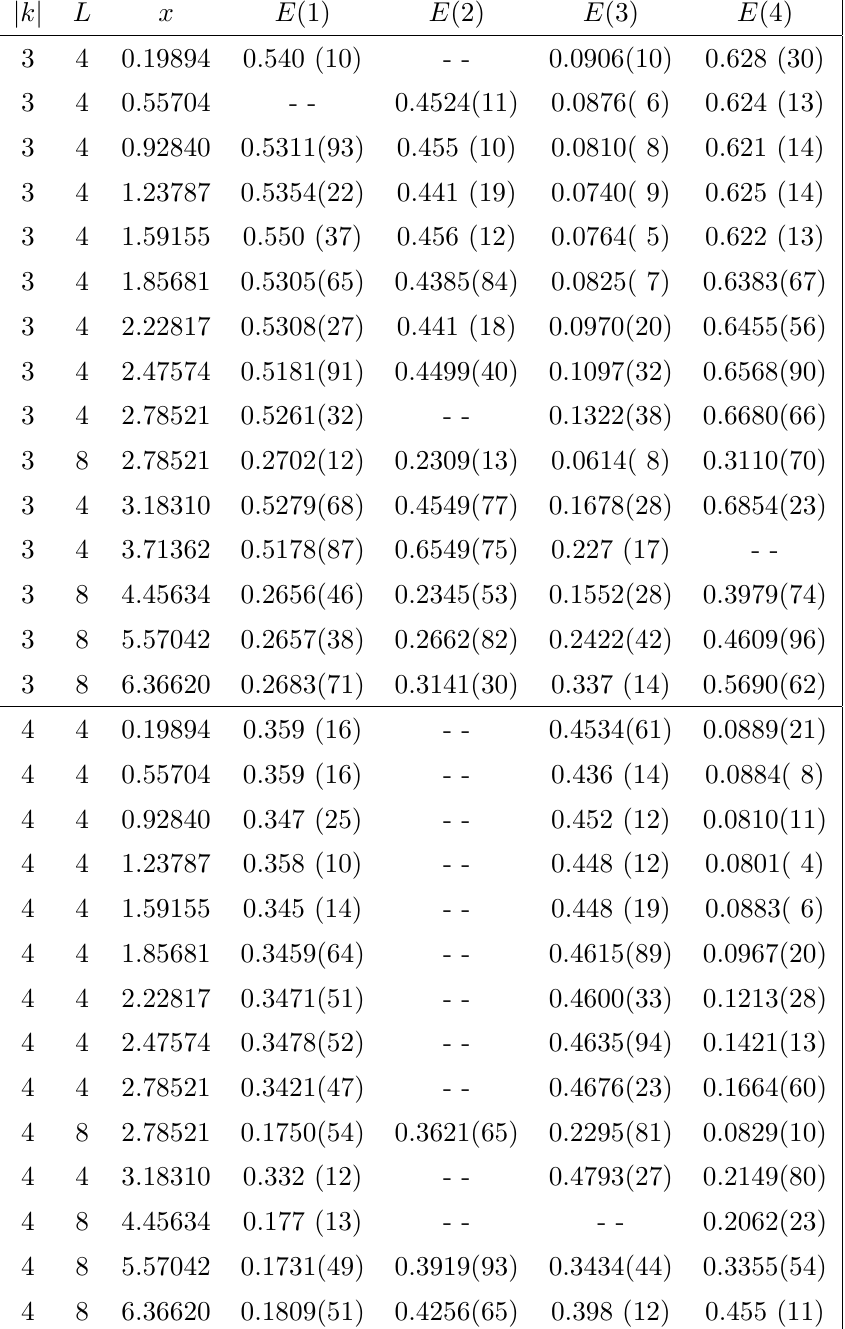
Table 10. SU(17) torelon energies (in lattice units)